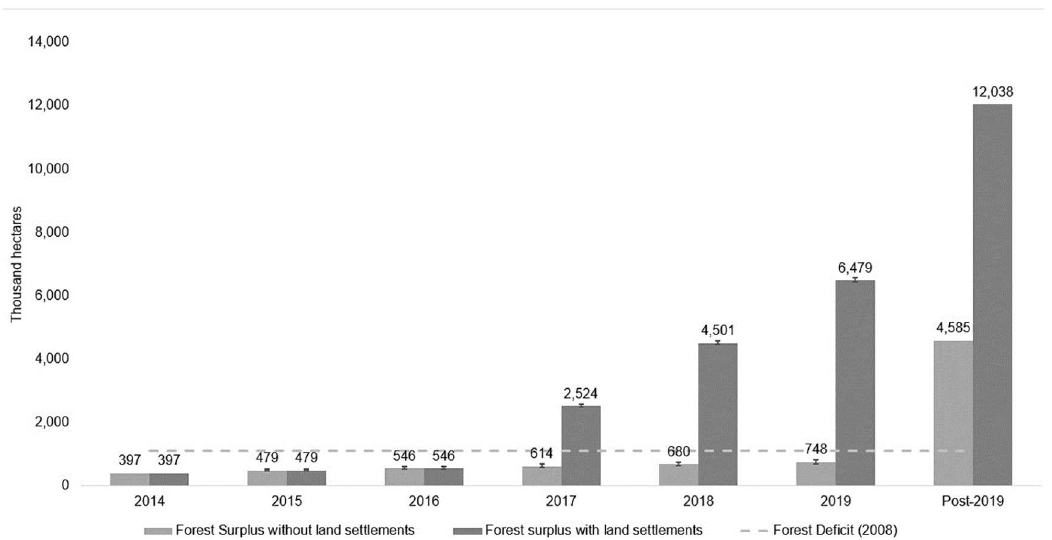
Fig 4. Estimated five-yearprojection (with the mean and 90% confidence interval) of forest surplus in Para´ State with and without land settlements.